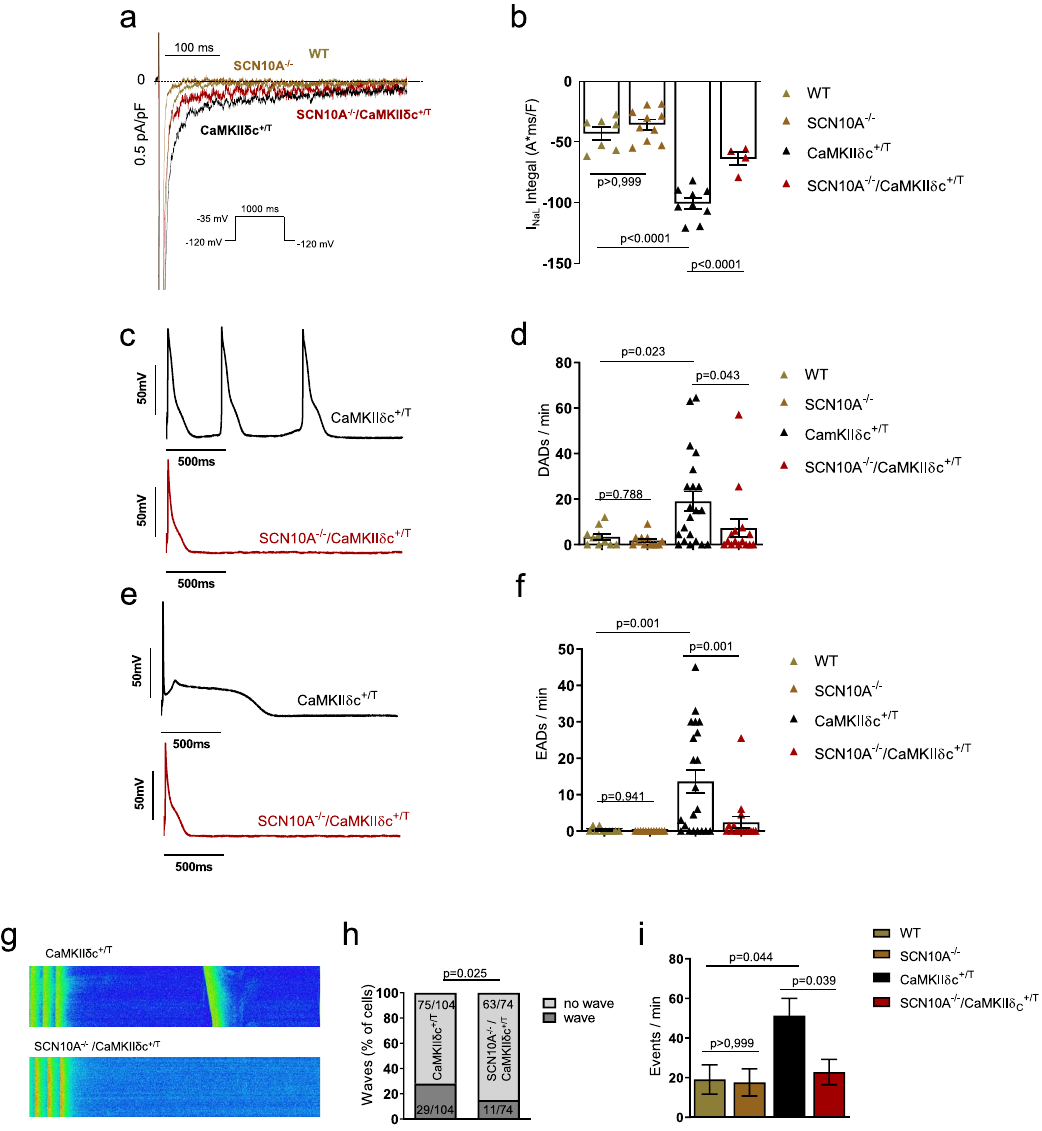
Fig. 5 Knockout of Scn10a (Na V 1.8) in CaMKII δ c + /T mice (SCN10A − / − /CaMKII δ c + /T ) signi fi cantly reduces I NaL and proarrhythmic triggers. a Original traces of I NaL in WT, SCN10A − / − , CaMKII δ c + /T , and SCN10A − / − /CaMKII δ c + /T mouse ventricular cardiomyocytes elicited using the protocol